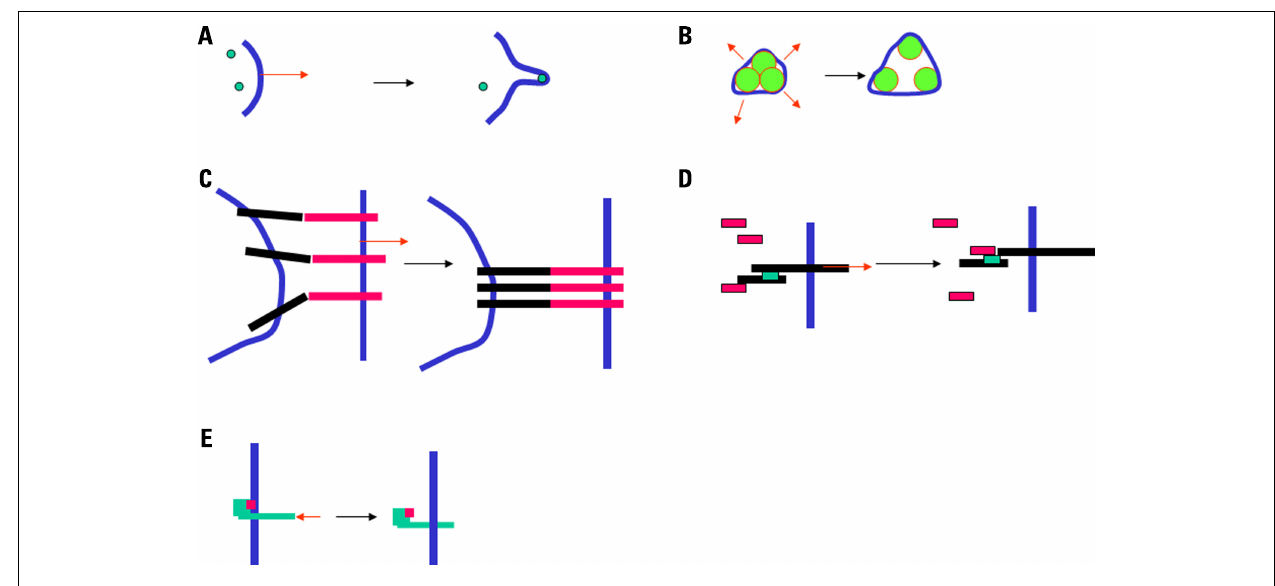
of adhesion receptors into a smaller area (Tözeren etal., 1989). (D) A force applied to a protein may result in a conformational change and exposure of docking sites shown as green rectangles (Del Rio etal., 2009). (E) A pulling or pushing force (red arrow) may alter the position of a protein with respect to the plasma membrane, resulting in the exposure of docking sites shown as pink rectangles (Xu etal.,